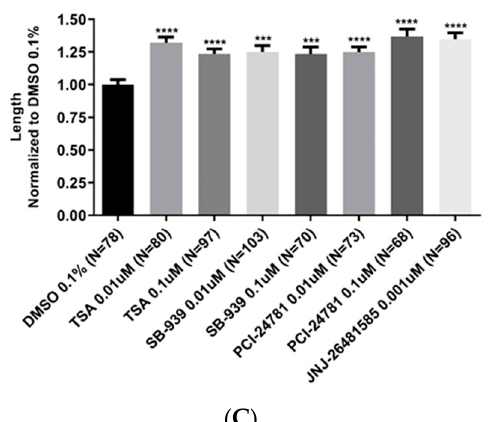
Figure 5. ( A ) Chemical structures of the test compounds; abexinostat (PCI24781), pracinostat (SB939), quisinostat (JNJ26481585), and trichostatin A (TCA). ( B ) Representative fluorescent images (20 × magnification) for each treatment. Human neural progenitor cells were differentiated for 5 days; then treated for 24 h with 0.1% DMSO (as control), and trichostatin A, JNJ26481585, SB939, and PCI24781 (as test compounds). Then immunostaining was performed with neuronal-specific β -tubulin III antibody (green) to visualize neuronal processes and quantify neurite lengths and Dapi (blue) to visualize cell bodies. ( C ) Statistical analysis of neurite length in various groups. As depicted, all test compounds were able to induce neurite outgrowth: PCI24781 (0.1 µ M) had the greatest effect with 37% increase compared with that of the 0.1% DMSO. It was followed by JNJ26481585 (0.001 µ M) with 34% increase. Trichostatin A was used as a positive control. Quantitative analysis of neurite length was done using ImageJ software. Two fields of view were analyzed per well. Two biological replicates were used per treatment and two independent experiments were done. Error bars represent SEM; *** p < 0.001, **** p < 0.0001.